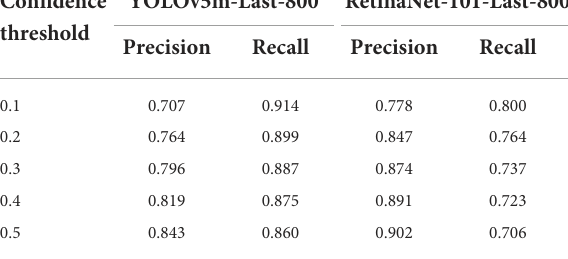
TABLE 6 The precision and recall scores by changing the confidence threshold from 0.1 to 0.5 while the IoU score is fixed at